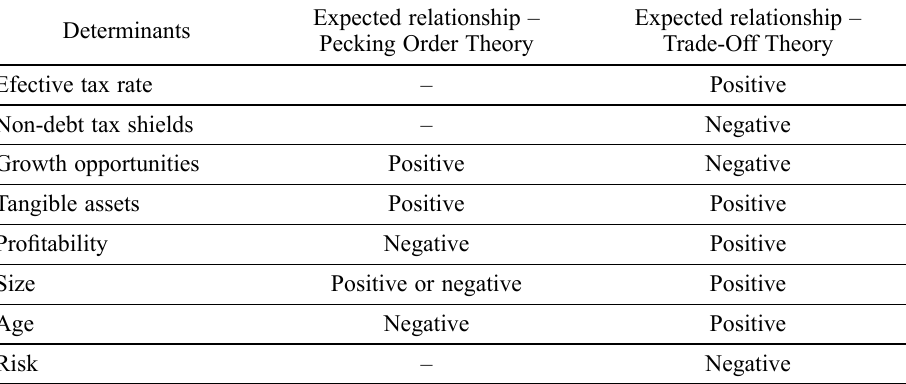
Table 1. Expected relationships between debt and